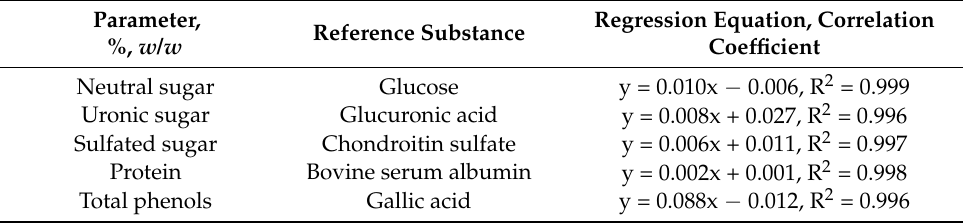
Table 1. Information about the chemical characterization of LECP.